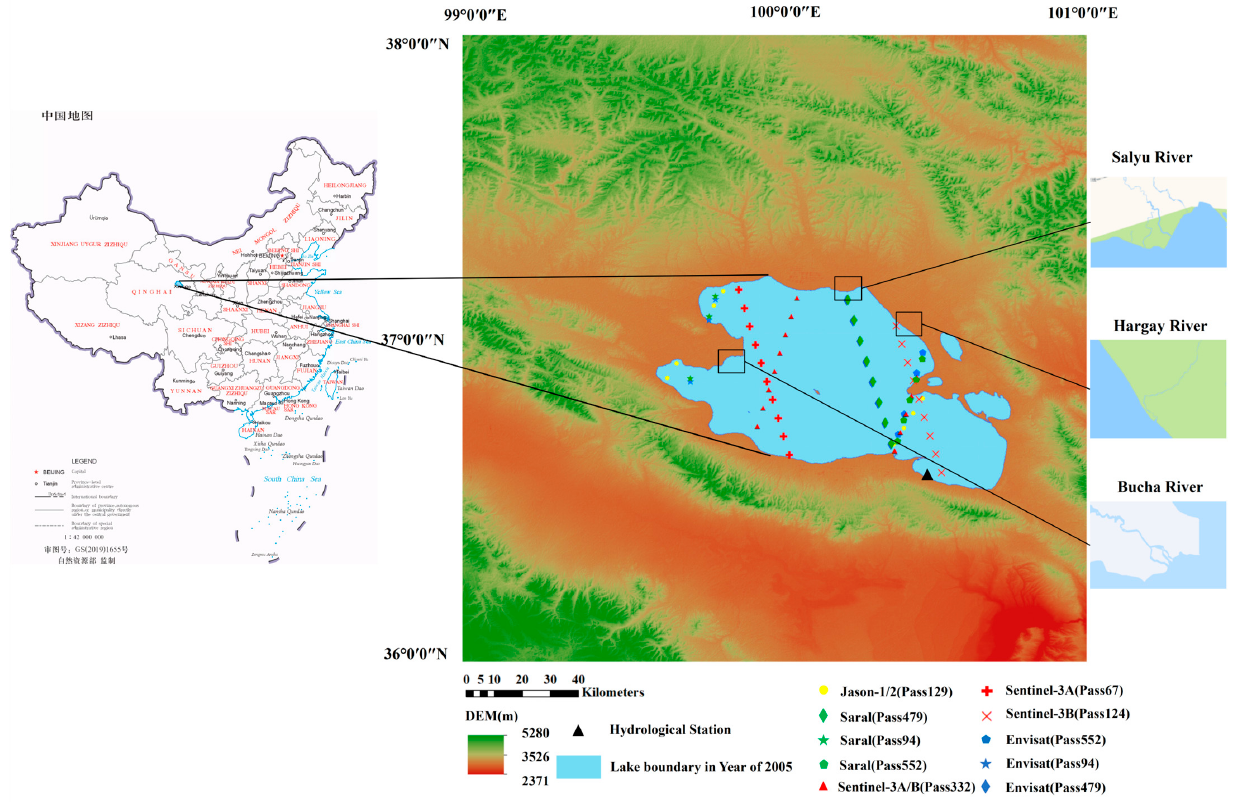
Figure 1. An overview map of the research region (the image shows a schematic depiction of the satellite routes of Sentinel-3A/3B, Saral, Jason-1/2, and Envisat RA-2 during the exact repeat mission periods).